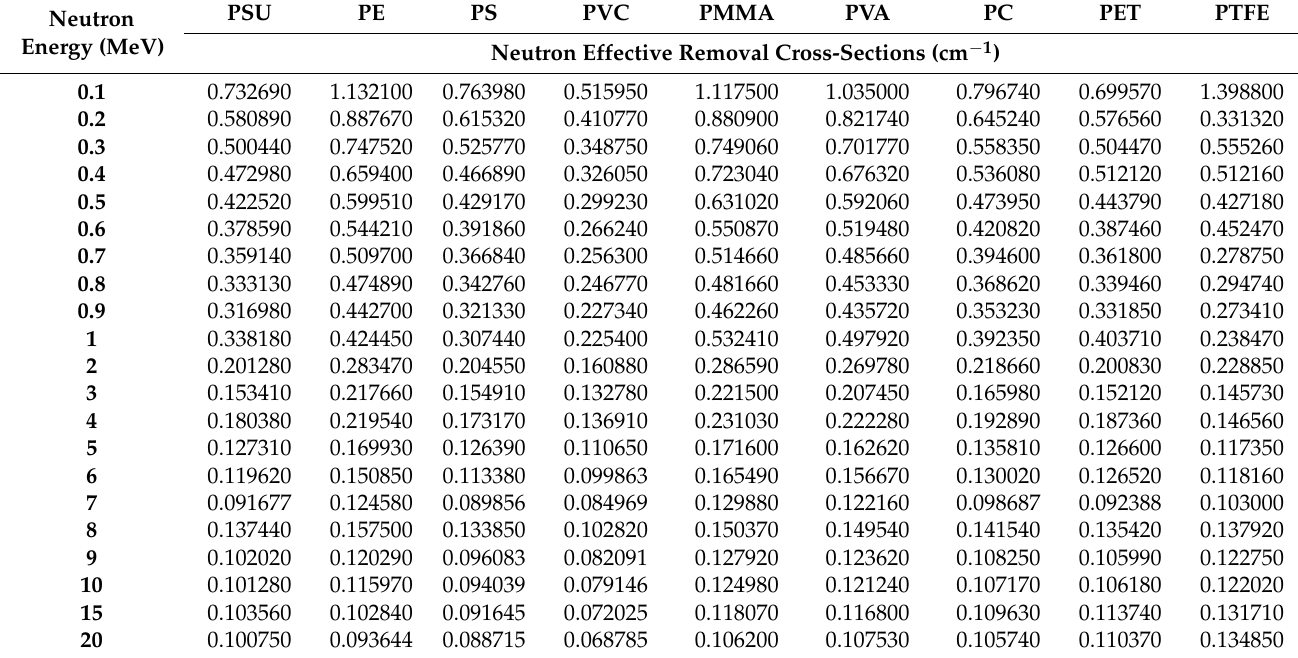
Table 10. Neutron effective removal cross-sections of different polymers compared to